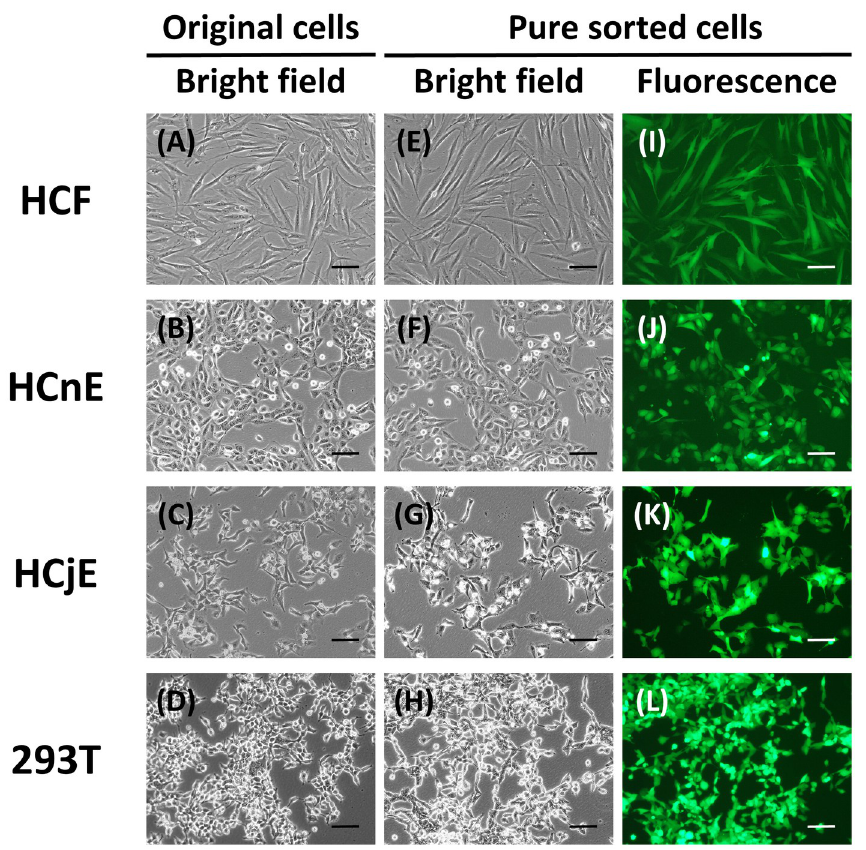
Fig 4. Morphology of the sorted EGFP-expressing cells. (A-D) The morphology of the primary HCFs, HCnEs, HCjEs, and 293T cells without transduction by EGFP-expressing pseudovirions but after repeated cell sorting was captured under a bright field microscope at 100 × magnification. (E-H) The morphology of the sorted EGFP-positive cells was captured using a light microscope at 100 × magnification. (I-L) In the same fields, fluorescence images of the sorted EGFP-positive cells were captured using a fluorescence microscope. This experiment was performed three times with similar results. Scale bars, 100 μ m. Other images for cell morphology are available at Figshare (DOI: 10.6084/m9.